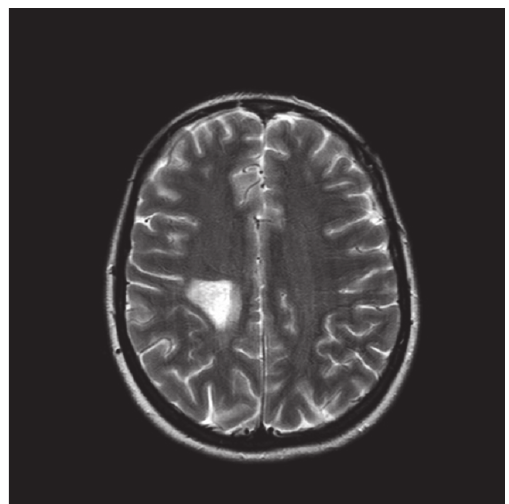
Figure 2: Axial head MRI.